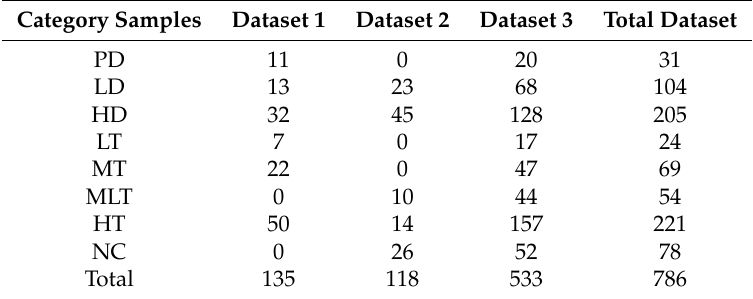
Table 1. Samples distribution of different